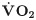
Heart rate (HR) and oxygen uptake (V˙O2) profiles during the combat simulation.Mean values (± standard deviation) of V˙O2 and HR, sampled 20 seconds (HR averaged every 20s) across the simulation. p–Significance level for interactions, calculated with repeated measures ANOVA (time x round, or time x interval), and ES (effect size) was calculated with Cohen’s f.